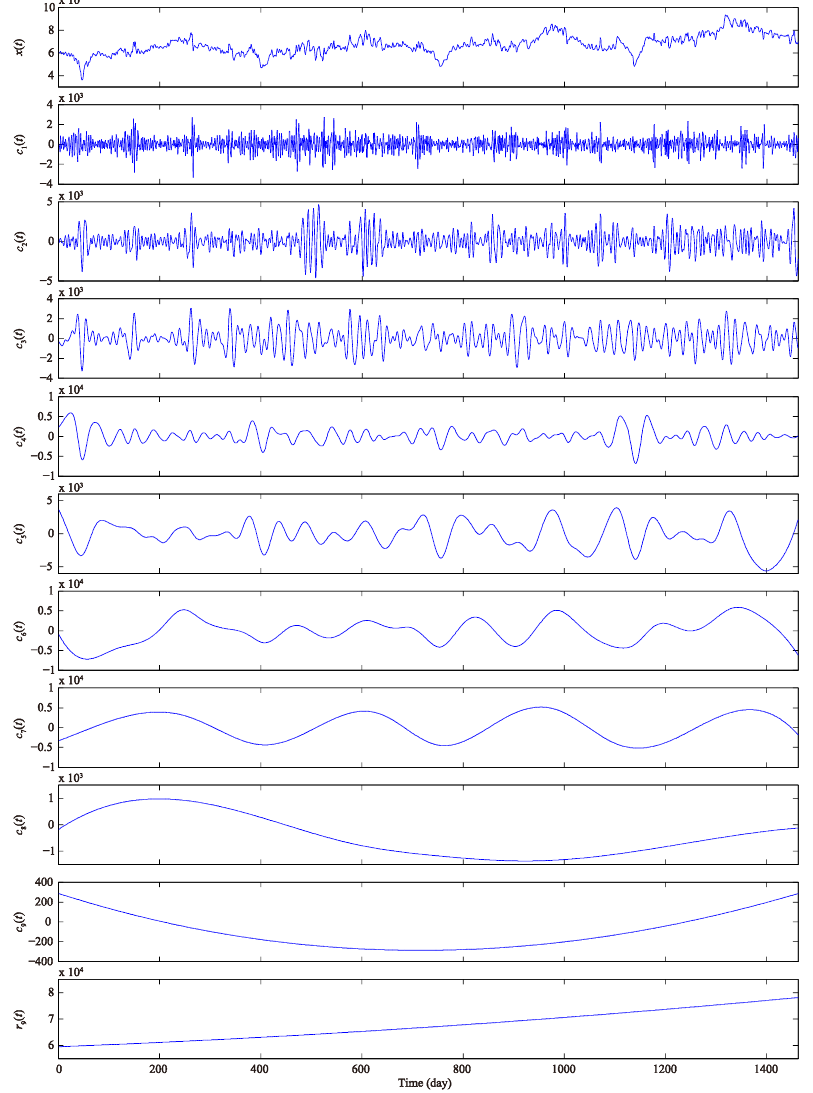
Figure 4. Decomposition results using EEMD method.